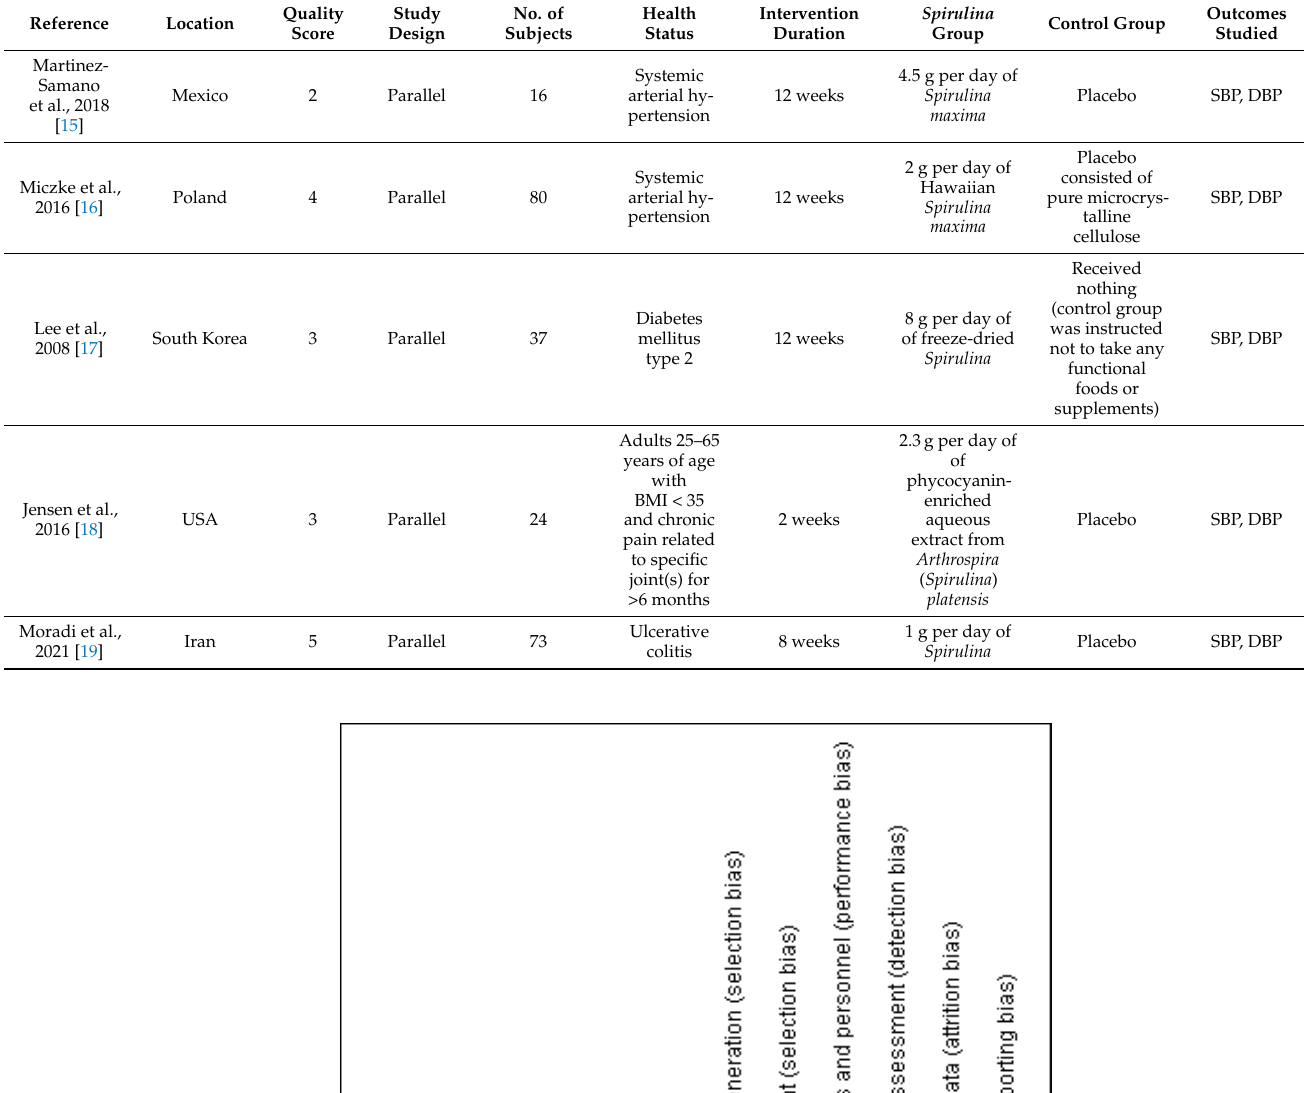
Table 4. Characteristics of included randomized controlled trials (RCTs).